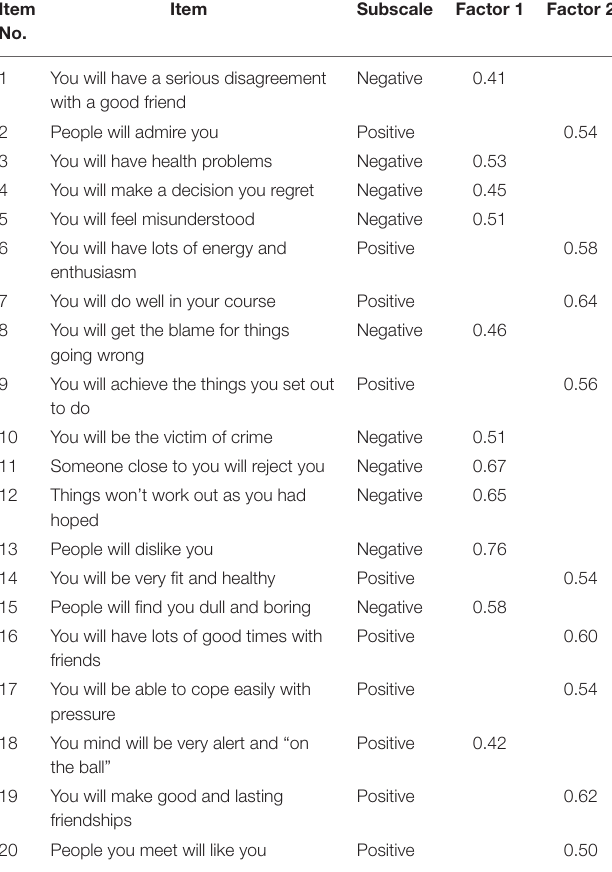
TABLE 4 | Results of regression analyses showing prediction of depression (BDI-II) and anxiety (STAI-T) by prospective imagery (PIT).